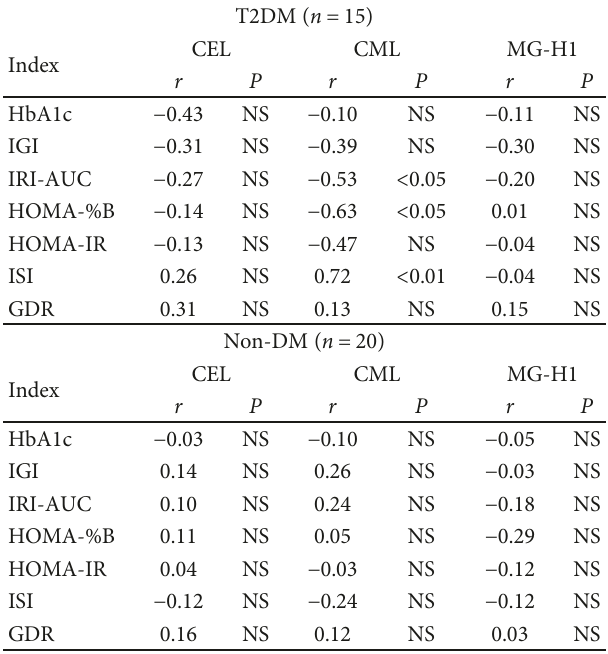
Table 4: Correlation coe ffi cients for the associations between AGEs and clinical